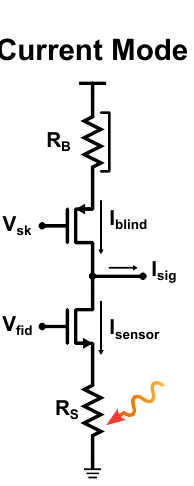
Figure 7. Commonly used current mode readout